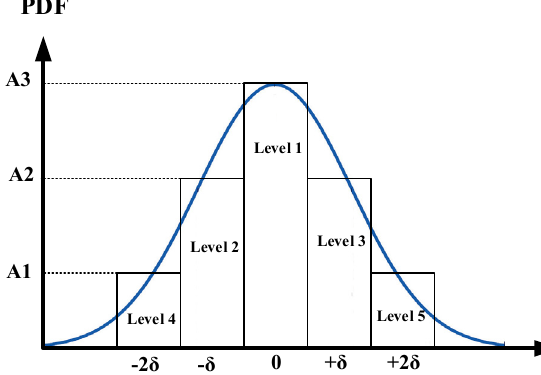
Figure 2. Probability density function with five level uncertainty.